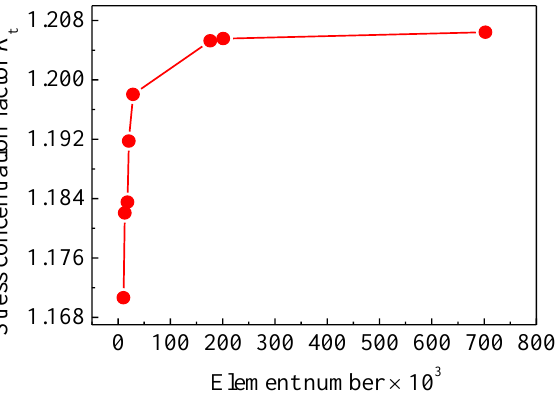
Figure 10. Variation of stress concentration factor with respect to element number.